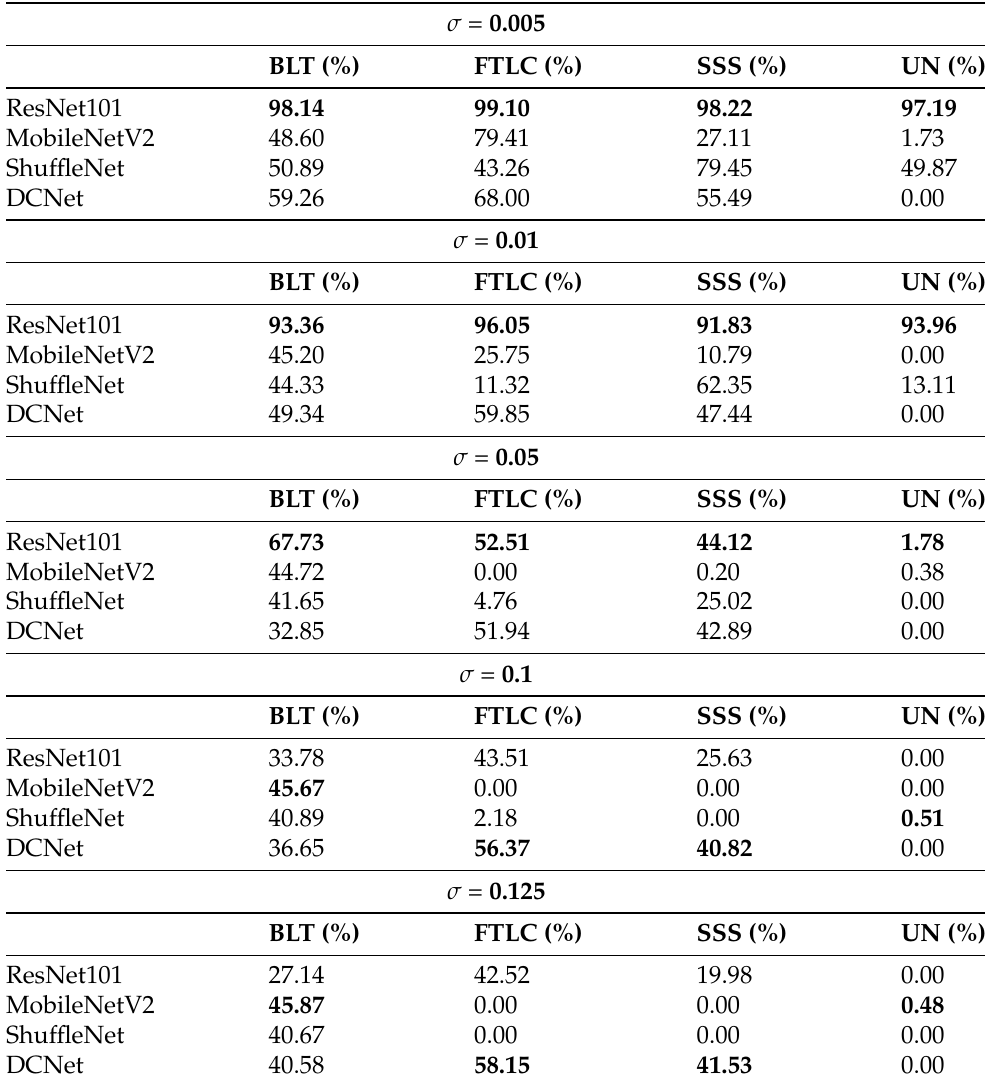
Table 3. Performance of convolutional neural network (CNN) models on different types of degrada- tion and additional zero-mean Gaussian noise (in F-measure). Bold fonts indicate the best results. σ =